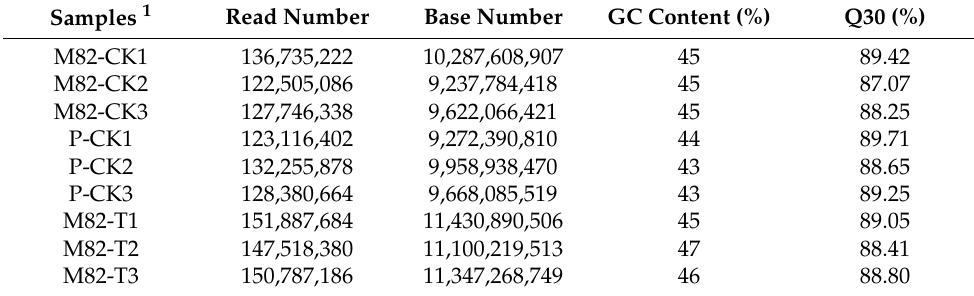
Table 2. Summary of RNA-seq data.